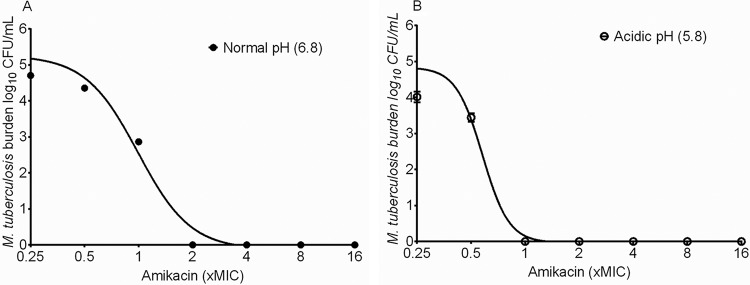
Amikacin efficacy against M. tuberculosis at different pHs. The maximal kill of log-phase-growth M. tuberculosis by amikacin at normal pH (A) was similar to that in slowly growing M. tuberculosis at low pH (B). The figure shows that maximal kill was actually achieved at lower concentrations at low pH.